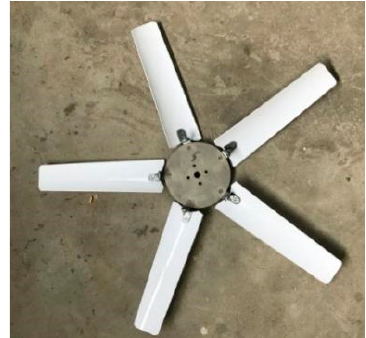
Figure 3. Photo of backward curved fan blades.